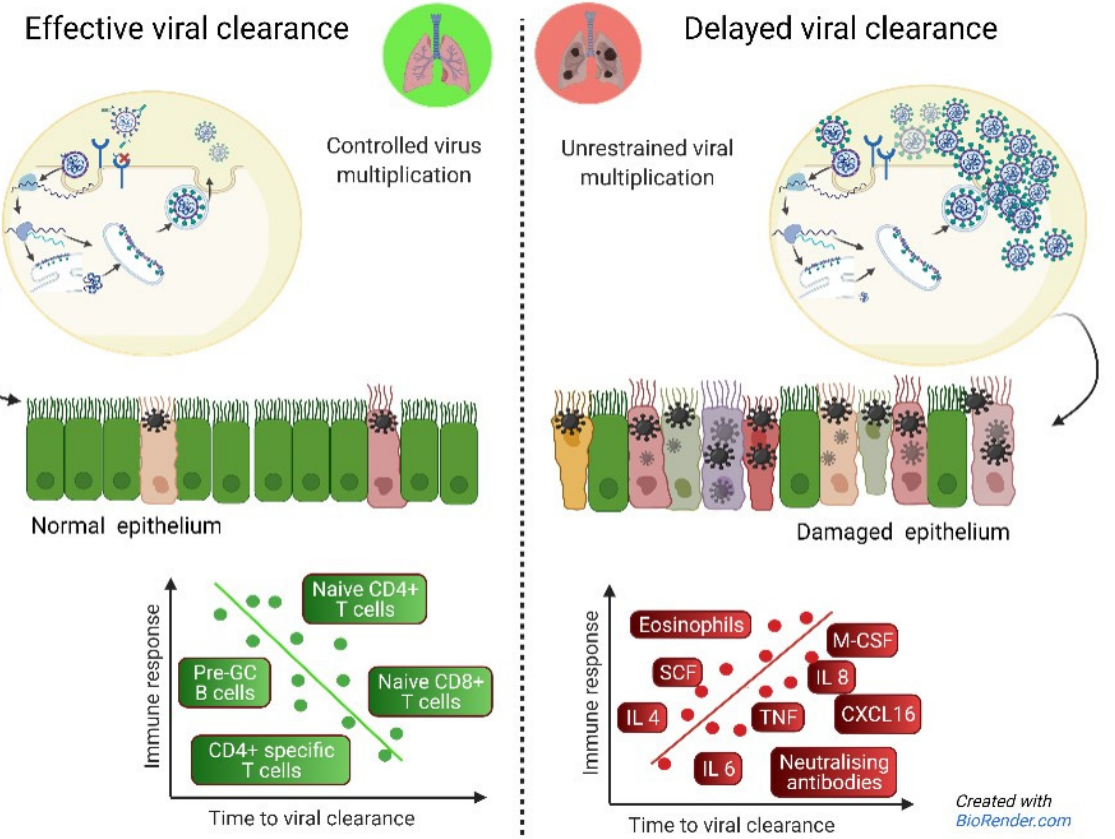
Figure 9. Hypothesis-generated drawing including all immune parameters in this study found to be associated with (delayed) viral clearance. Pre-GC; pre germinal center B cells; circulating naïve B cells [32]. Adapted from “Coronavirus Replication Cycle”, by BioRender.com, accessed 1 January 2022.